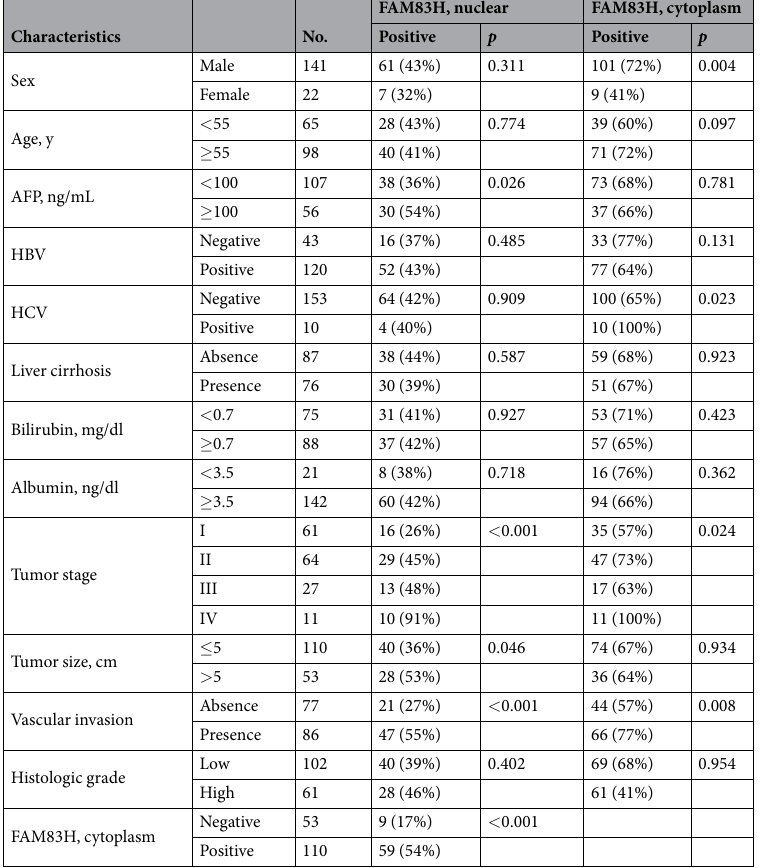
Table 1. Clinicopathologic variables and the expression of FAM83H in 163 hepatocellular carcinomas. AFP, a-fetoprotein; HBV, hepatitis B virus; HCV, hepatitis C virus. The p values were calculated by Chi square